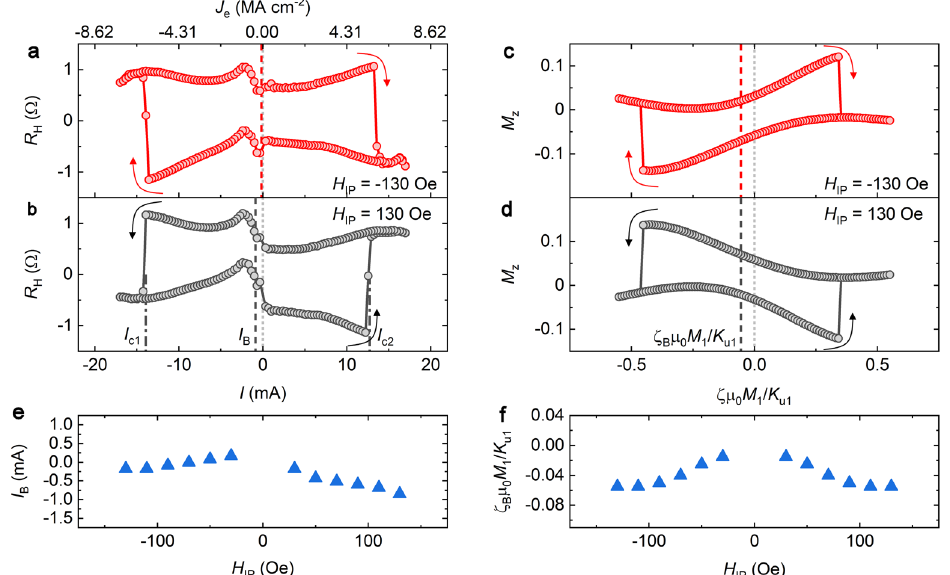
Fig. 3 Asymmetric current-driven switching of magnetization. a , b Current-driven magnetization switching with the application of a ( a ) negative and ( b ) positive H IP . The anomalous Hall part of the Hall resistance R H that is proportional to the perpendicular magnetization M z is dominant in the interpretation. Positive values of current and fi eld refer to corresponding vectors pointing along the y axis and negative to the − y axis. Dash-dotted lines in ( b ) indicate positions of the negative ( I c1 ) and positive ( I c2 ) switching currents for the positive H IP . Dashed lines indicate positions of the switching current biases I B for a positive (black) and negative (red) H IP . c , d Numerical calculations of the asymmetric SOT switching, with the application of a ( c ) negative and ( d ) positive H – Moriya interaction (DMI) vector D − x axis with the amplitude of D = − 0.1 A IP . The interlayer Dzyaloshinskii Int along the Int Int was adopted in calculations. e The current bias I B as a function of H IP . f Numerical calculations of the torque bias ζ B as a function of H IP . Arrows represent switching